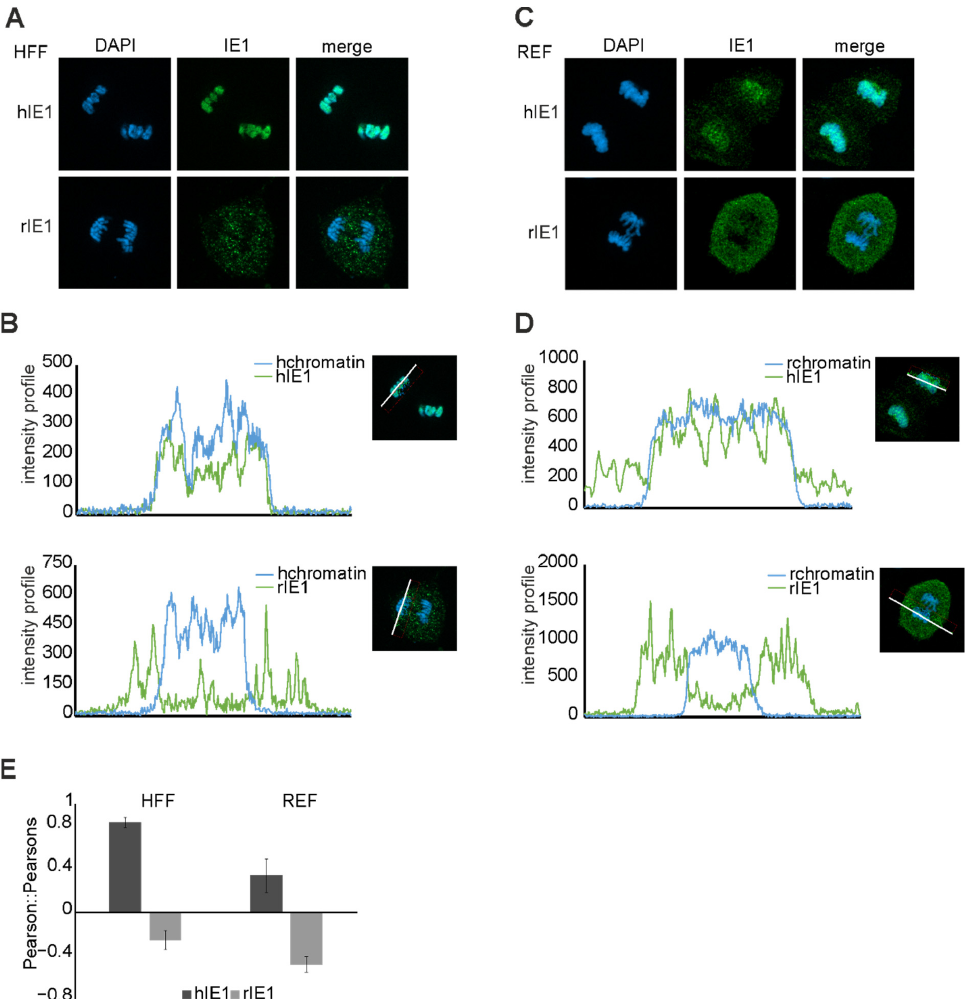
Figure 8. Chromatin tethering by IE1 in cross-species experiments. Immunofluorescence analyses of co-localization of IE1 homologs with mitotic chromatin in HFF ( A ) and REF ( C ) cells. The cells were treated with doxycycline for 24 h and then fixed. IE1 was stained with mAB Flag. Chromatin was stained with DAPI. The intensity profiles ( B , D ) and Pearson co-localization coefficients ( E ) were generated by the Zen blue software (30 cell nuclei per sample).